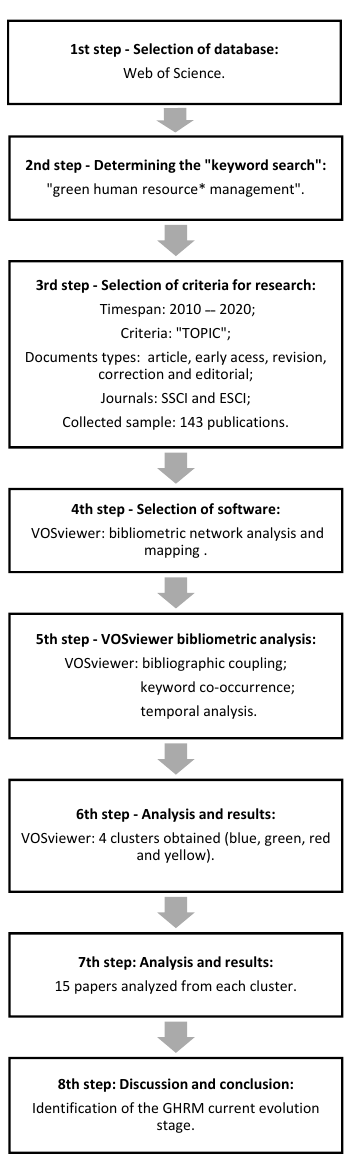
Figure 1. Workflow of this Bibliometric Review.